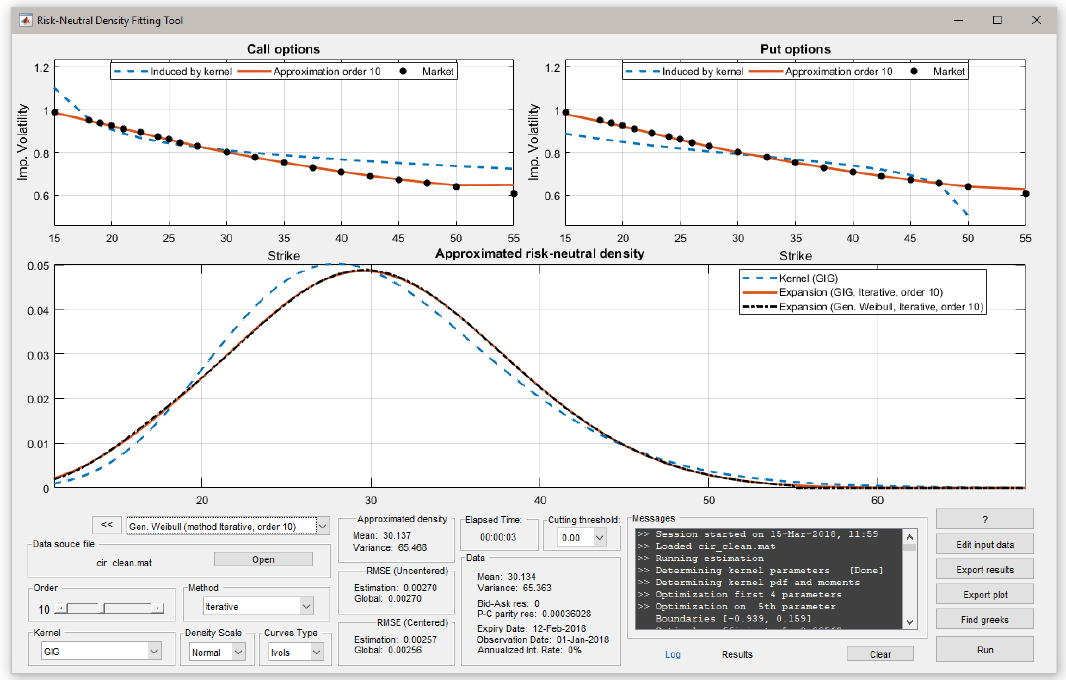
Figure 8. The data is generated by a CIR density with parameters k = 1.71, ζ = 0.097, η = 0.577 and τ = 30/365.